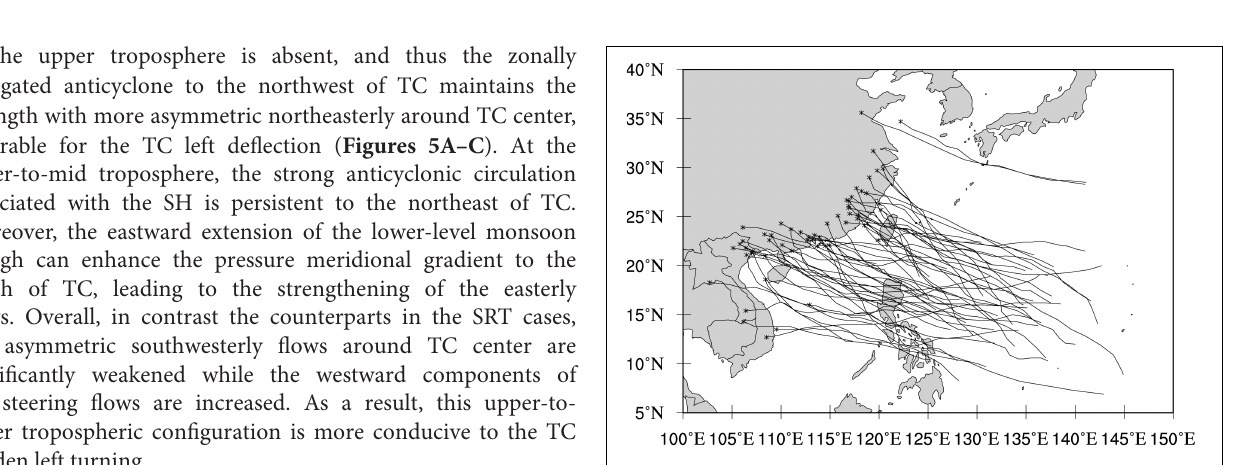
Roles of the Different Dominant Wave Modes As described in section “Case classification and statistical characteristics,” the sudden TC track turnings in the WNP can be grouped into the five dominant wave categories. The